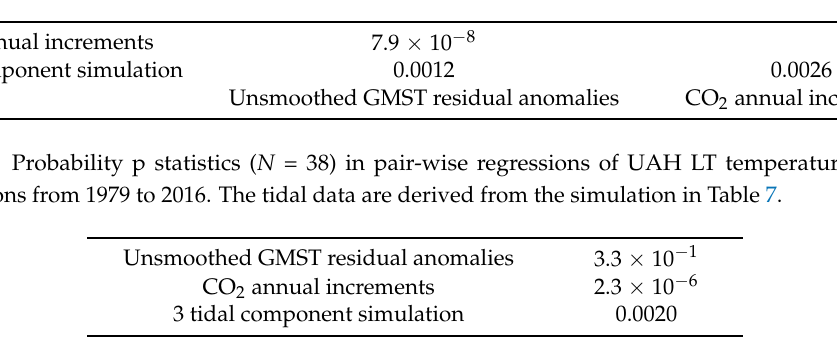
Table 8. Probability p statistics ( N = 58) in pair-wise regressions with higher-frequency oscillations from 1959 to 2016. The tidal data are derived from the simulation in Table 7.